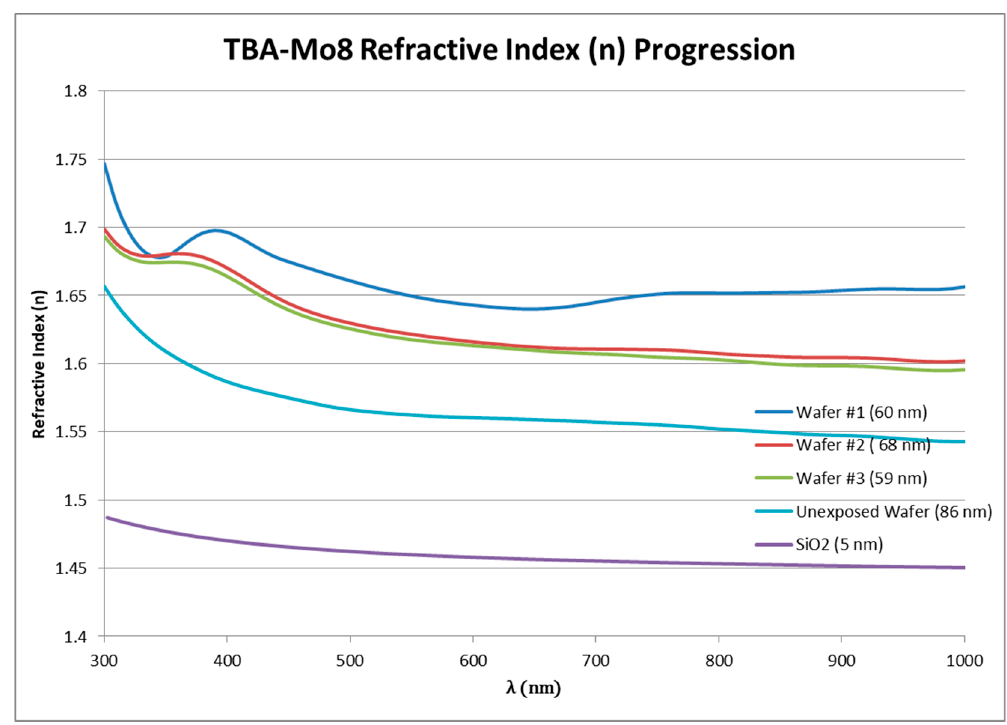
Figure 9. Octamolybdate ellipsometry model building progression of refractive index and calculated thickness.